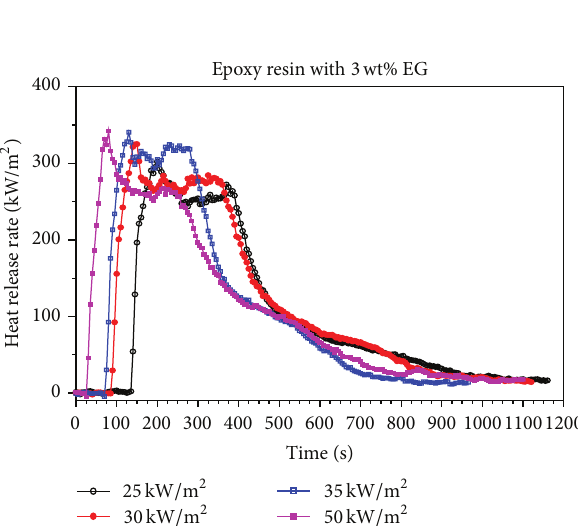
Figure 6: Plots of sample composition, time-to-ignition, and exter- nal heat